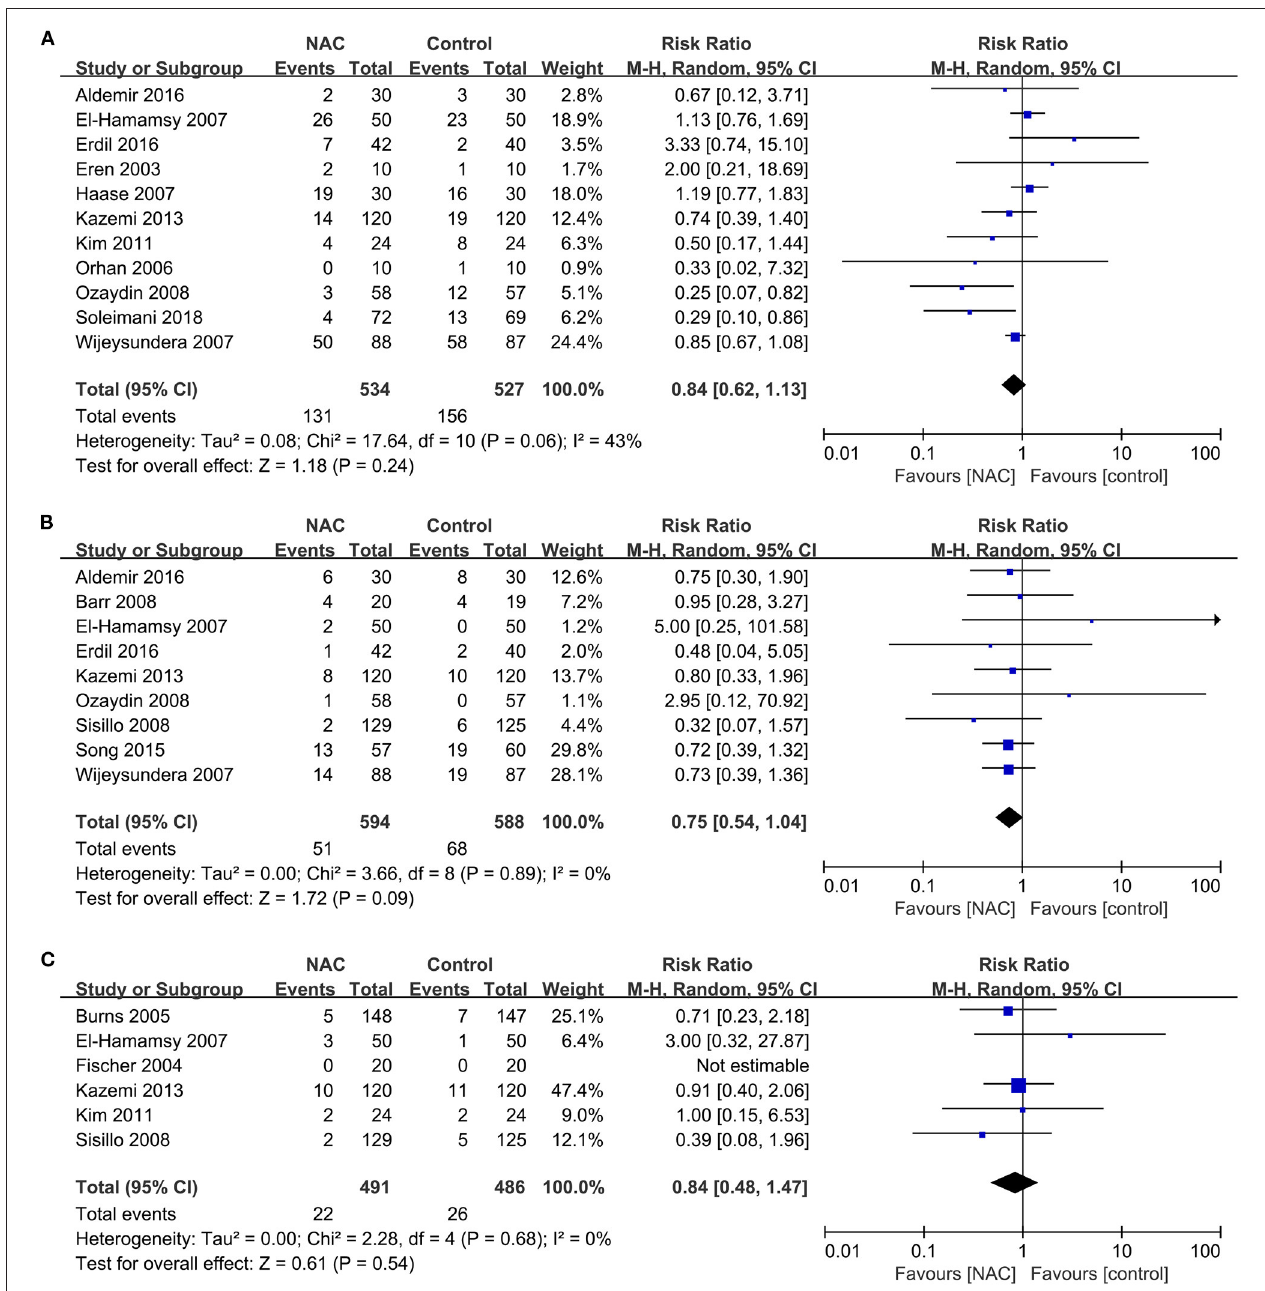
FIGURE 6 | Forest plot of the effects of NAC on the incidence of MACEs. (A) Forest plot of arrhythmia. (B) Forest plot of cardiac insufficiency. (C) Forest plot of AMI.